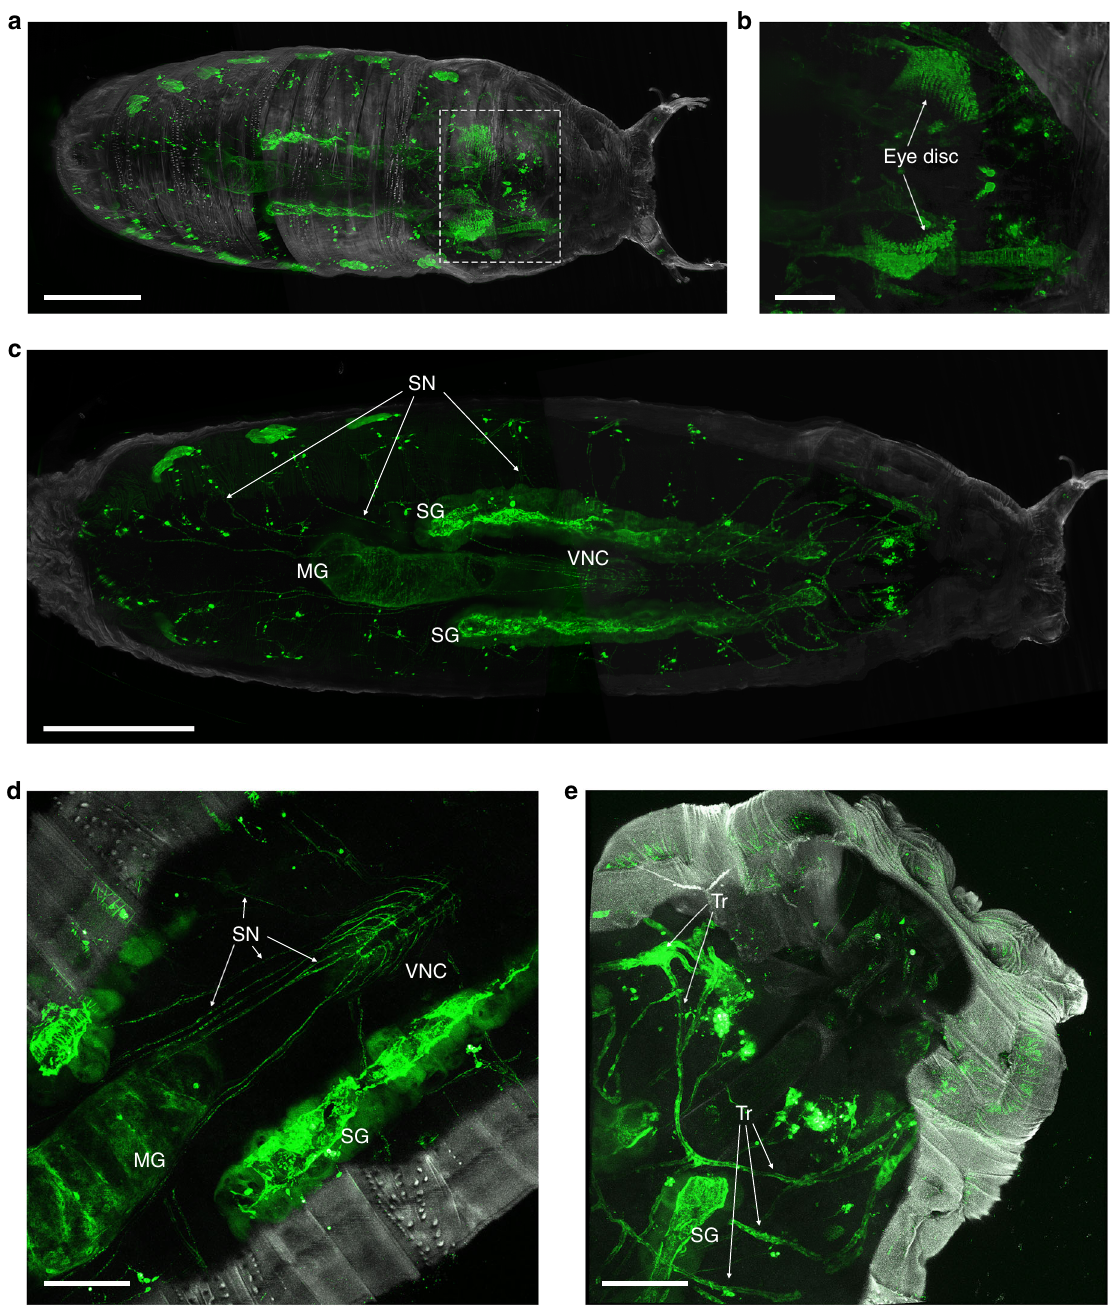
Fig. 3 Imaging of FlyClear treated prepupa using confocal and optimised aspheric ultramicroscope system. a – c Light-sheet images and d , e confocal images of GFP expression in the developing visual system, segmental nerves (SN), and trachea (Tr). a Imaging of whole prepupa. b Clipping plane shows higher magni fi cation of boxed area in a displaying the eye discs of prepupa. c Dorsal view of a clipping plane in undisected prepupa showing mid gut (MG), salivary glands (SG), segmental nerves (SN) and the ventral nerve cord (VNC). d Higher magni fi cation showing the innervation of the SN into the VNC. e Higher magni fi cation showing trachea (Tr) and salivary glands (SG). Images in a – c were acquired with a 10x water-immersion objective (Olympus, UMPlanFLN, 0.3 NA, WD = 3.5 mm) with custom-made correction of optics for a refractive index of 1.45 (WD = 3.5 mm after correction). Images d , e were acquired with a 20x immersion objective (Leica, HCX PL APO CS, 0.7 NA, 260 µ m WD). Genotype: Peb-Gal4 UAS-mCD8::GFP . Scale bars represent 500 µ m in a , c , 200 µ m in c , d and